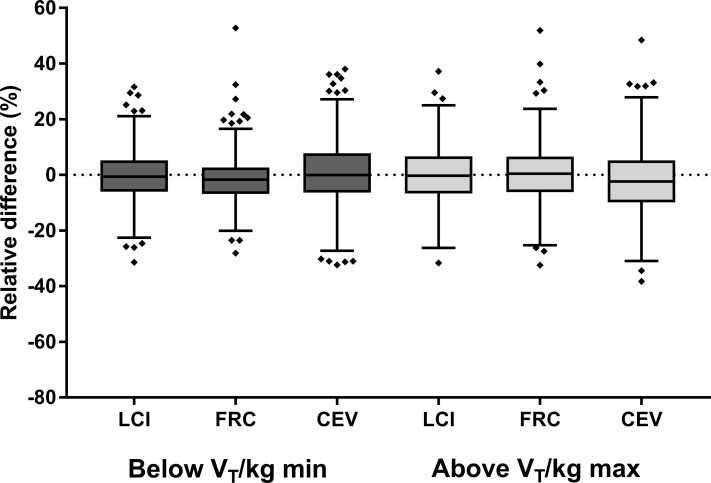
Relative difference in MBW outcomes for trials with VT below 9 ml/kg (black boxes) and those above 15 ml/kg (grey boxes) compared to same-visit trials that fell within the ideal tidal volume (VT) range.MBW outcomes assessed include the lung clearance index (LCI), functional residual capacity (FRC) and cumulative expiratory volume (CEV).